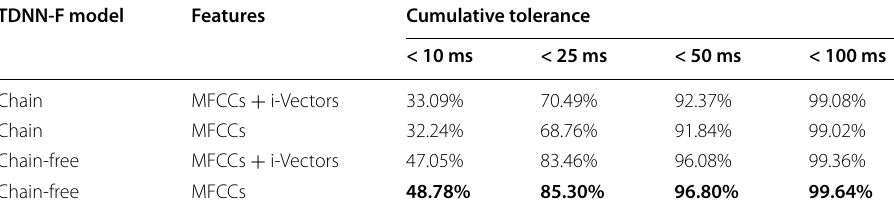
Table 13 Phone boundary results for the female